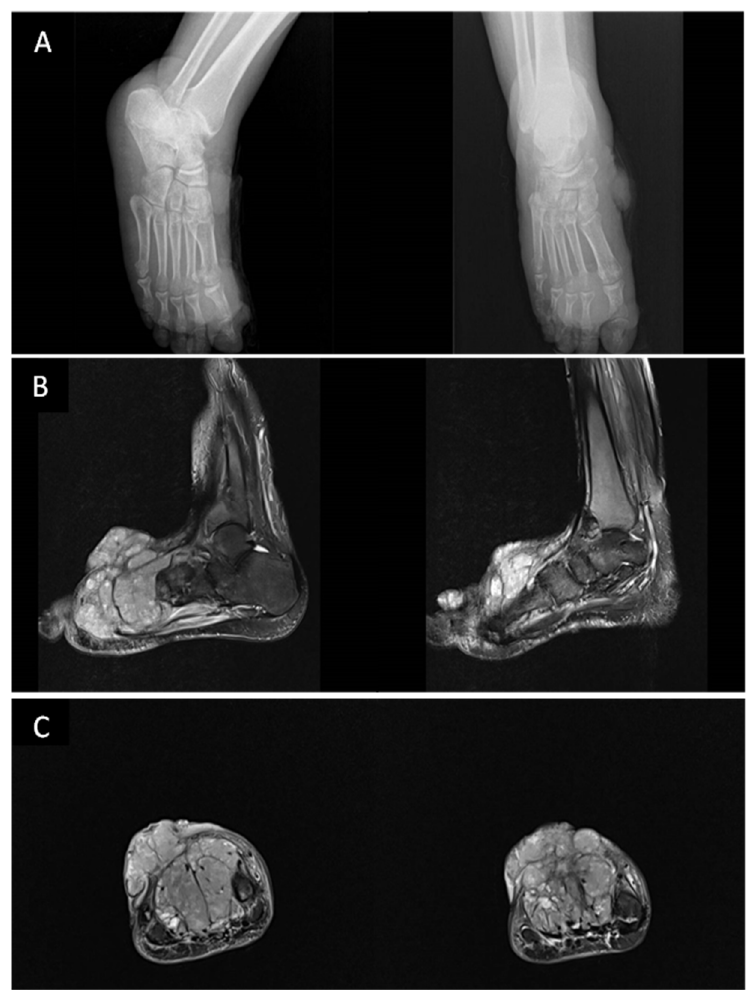
Figure 2. Imaging of the patient described in Figure 1. ( A ) Plain radiograph in the anteroposterior and lateral projection of the right foot showing lobulated soft tissue swelling involving the anterior and medial malleolus aspect without any associated periosteal reaction of the adjacent bones. (November 2015). ( B , C ) Magnetic resonance imaging (MRI) (Sagittal T2 FS images ( B ) Coronal T2 FS ( C )) shows multiple enhanced exophytic cutaneous and subcutaneous masses of the right foot with osseous involvement of underlying structures (the main lesion overlying the second, third, and fourth metatarsal bones, lobulated dorsal mass adjacent to the middle phalange of the second toe) associated with a local invasion of the extensor tendons and close contact to flexor tendons (February